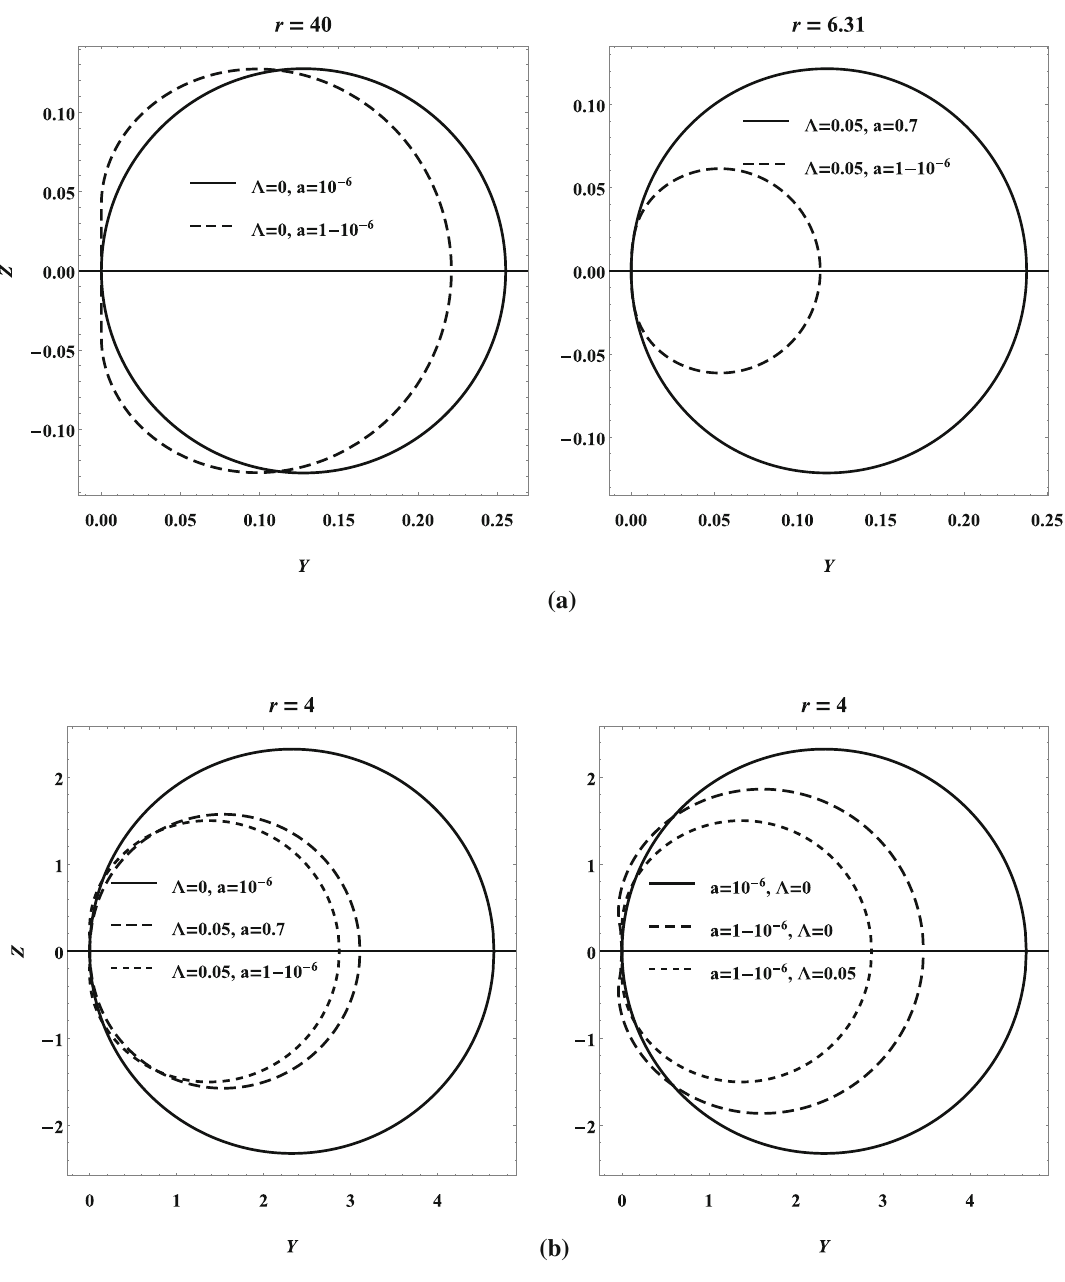
Fig. 7 Shadows of rotating Hayward–de Sitter black holes with g = 0 on projective plane ( Y , Z ) for selected parameters. r is the distance from the observer to the black holes. Here we set M = 1. a Shadows